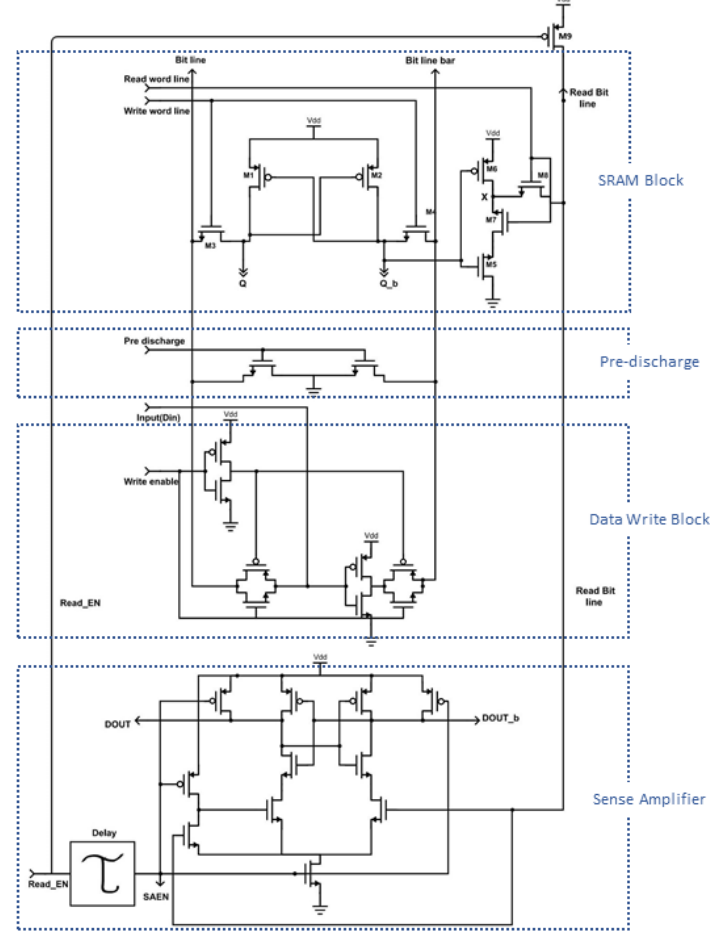
Figure 14. Proposed PLNA 8T SRAM cell operation.